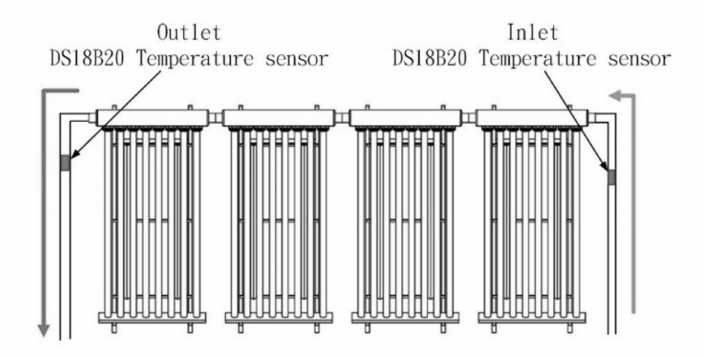
Figure 5. Temperature sensor placement in and out of the water port of solar water heater